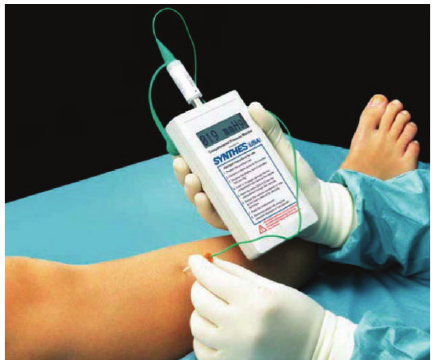
Figure 3: Synthes (West Chester, PA) hand-held compartment pres- sure